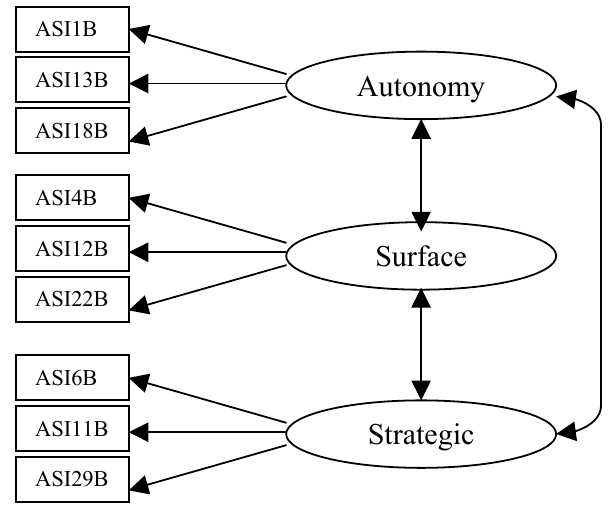
Figure 1. Theoretical full three-factor model used for confirmatory factor